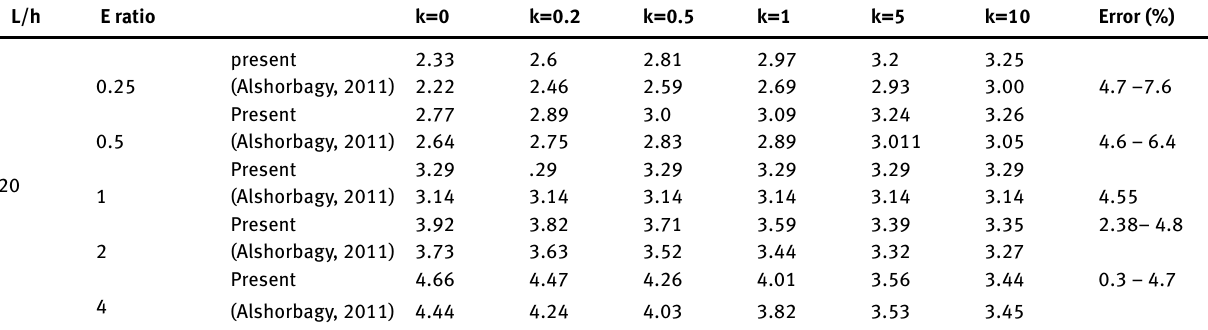
Table 4: First non-dimensional frequency (λ) for different young modulus ratio L/h E